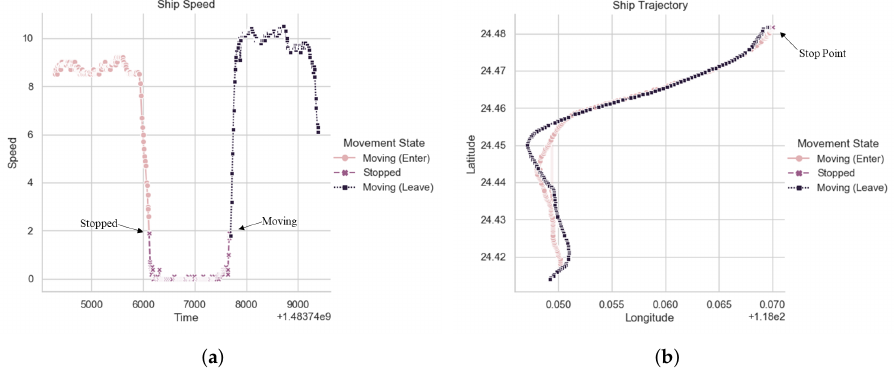
Figure 2. An example of ship point detection. Different colors lines correspond to different navigation states in the figure. ( a ) Ship Speed Variation Curve; ( b ) Ship Movement